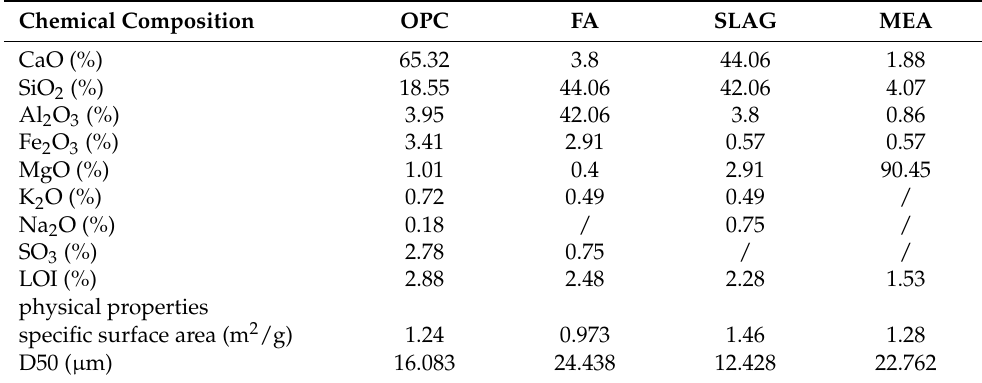
Table 1. Chemical compositions and physical properties of the raw materials. Chemical